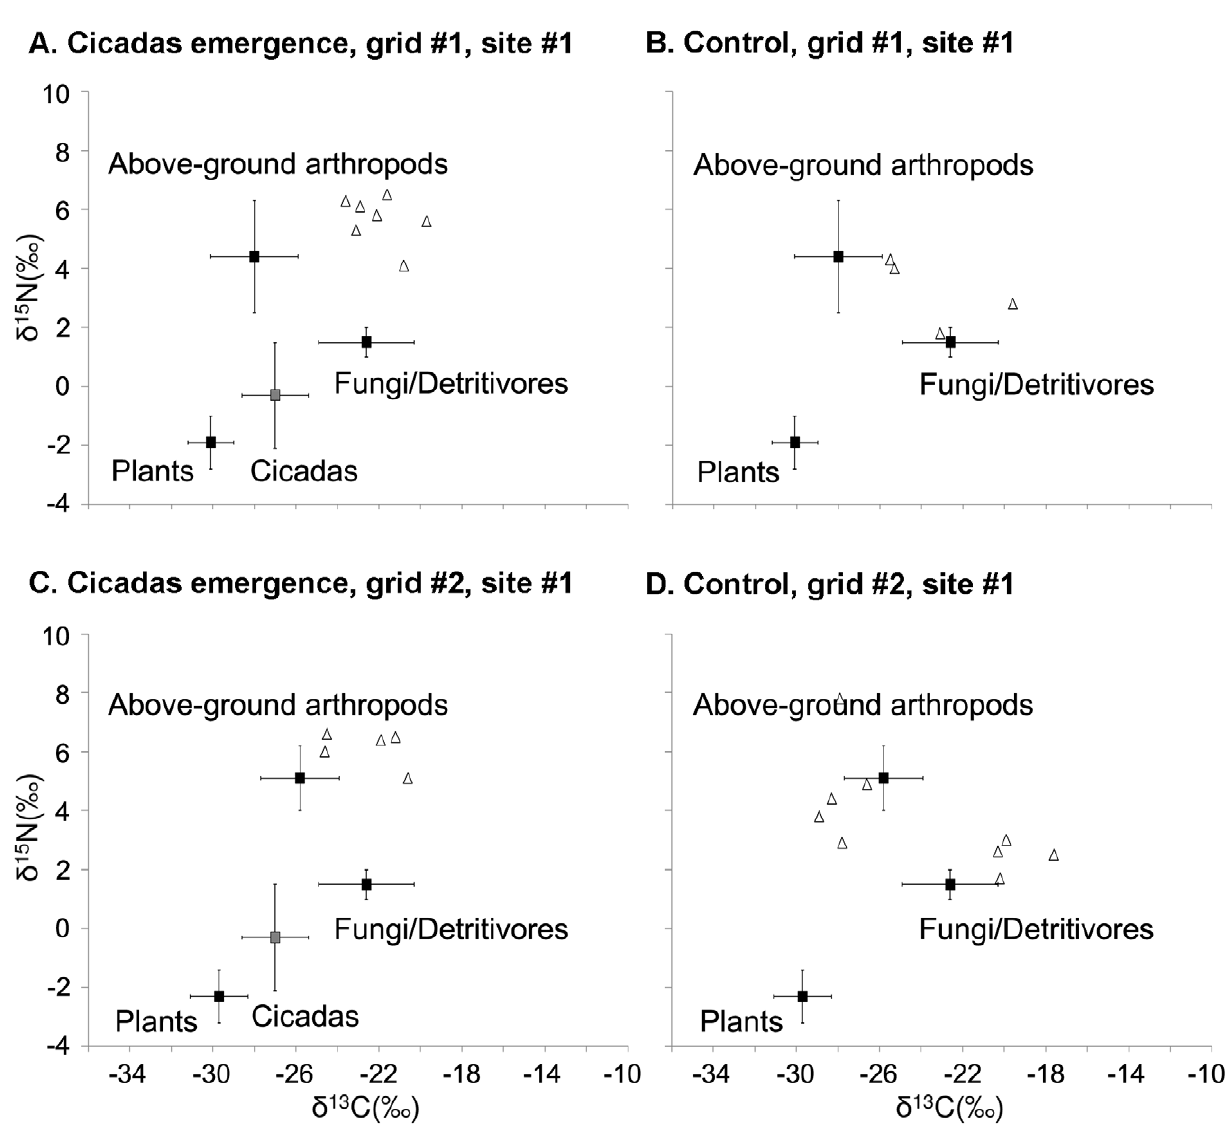
Figure 2. The isotope values of the dietary sources and mice in the cicadas emergence experiment. The squares (means) and whiskers (s.d.) denote grid-specific isotope values of the dietary sources with the exception of the fungus-detritivore group, for which generic values were used. The triangles denote the isotope values of individual mice. The variability of source isotope values was incorporated into the Bayesian model using s.d. Because the model also incorporates the variability associated with discrimination factors, the values for the mice plotted here were not pre-adjusted for trophic enrichment. Note that grid # 1 and grid # 2 were both repeatedly sampled in 2003 (used as controls) and 2004 (used as cicadas treatments). Therefore, the isotope values of the dietary sources were the same between A and B (grid # 1), and between C and D (grid # 2). doi:10.1371/journal.pone.0017970.g002 higher C:N ratio than above-ground arthropods ( x 2 =19.87, P , 0.0001). The C:N ratio of the millet seeds was four times higher than that of the cicadas (mean 6 standard error: C:N millet = 28.06 6 3.27, C:N cicadas =6.21 6 0.50), and the C:N ratio of the plants was three times higher than that of the arthropods (C:N plants = 18.93 6 1.58, C:N above-ground arthropods =5.24 6 0.35). These results indicate that millet seeds were of lower nutritional values to the mice than cicadas, and this difference in nutrient quality is characteristic of that between plant and animal foods in the study system.